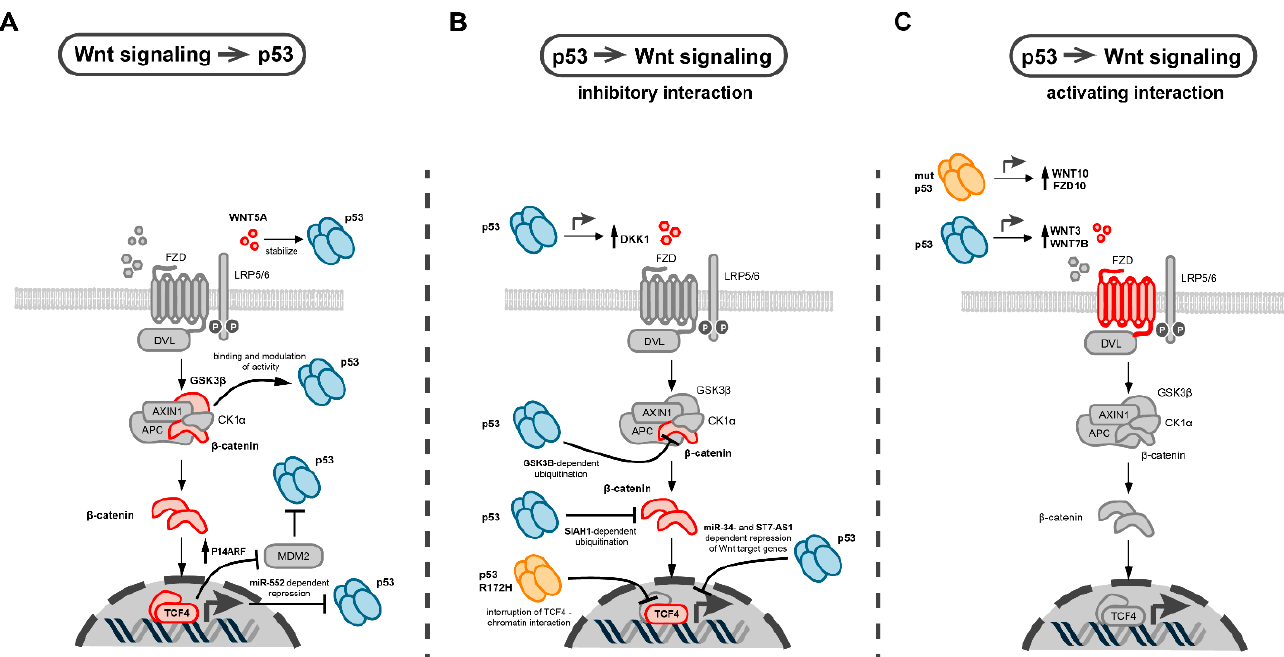
Figure 3. Molecular interactions between p53 and Wnt signaling in cancer. ( A ) Effects of Wnt pathway components on p53 function. These include β -catenin-dependent upregulation of P14ARF, an inhibitor of MDM2, the main negative regulator of p53. Other interactions include the modulation of p53 function by direct interaction with GSK3 β , Wnt-dependent repression of p53 transcription via miR-52, and stabilization of p53 by WNT5A. Interacting Wnt pathway components are colored in red. ( B , C ) Biological effects of wild-type (blue symbol) and mutant p53 on different Wnt pathway components (colored in red). Inhibitory ( B ) and activating ( C ) interactions are shown. Arrows indicate activation and T-shaped arrow heads indicate inhibitory interactions. The main inhibitory effects of p53 on Wnt signaling include GSK3 β and SIAH1-dependent ubiquitination of β -catenin, miRNA and lncRNA-mediated repression of Wnt target genes, and induction of secreted Wnt antagonists such as DKK1 ( B ). p53 stimulates Wnt signaling by increasing the expression of different WNT ligands and Fzd receptors ( C ).